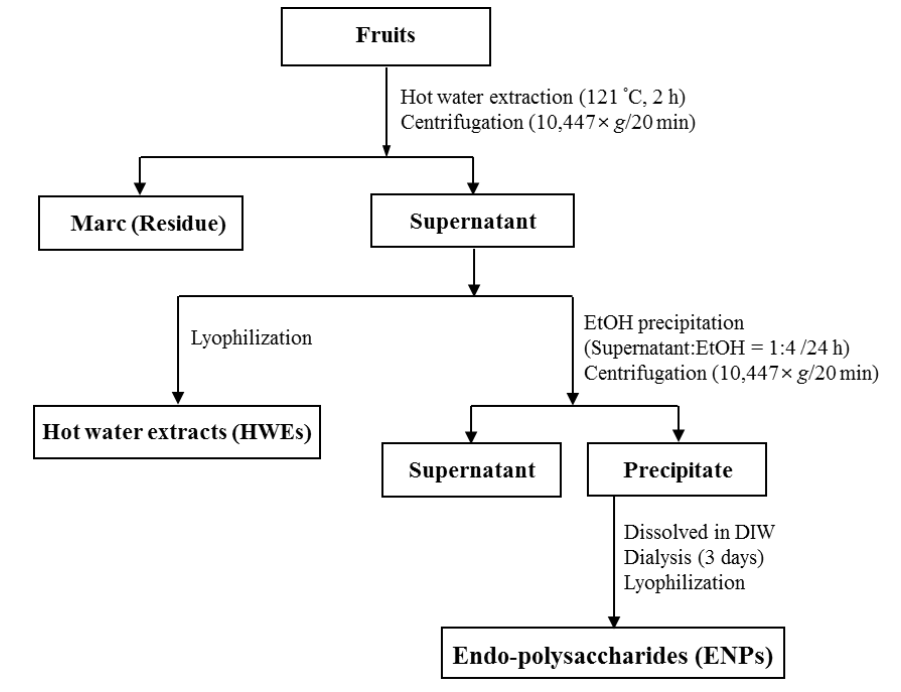
Figure 5. Schematic diagram for the processing of hot water extracts and endopolysaccharides from medicinal fruits.